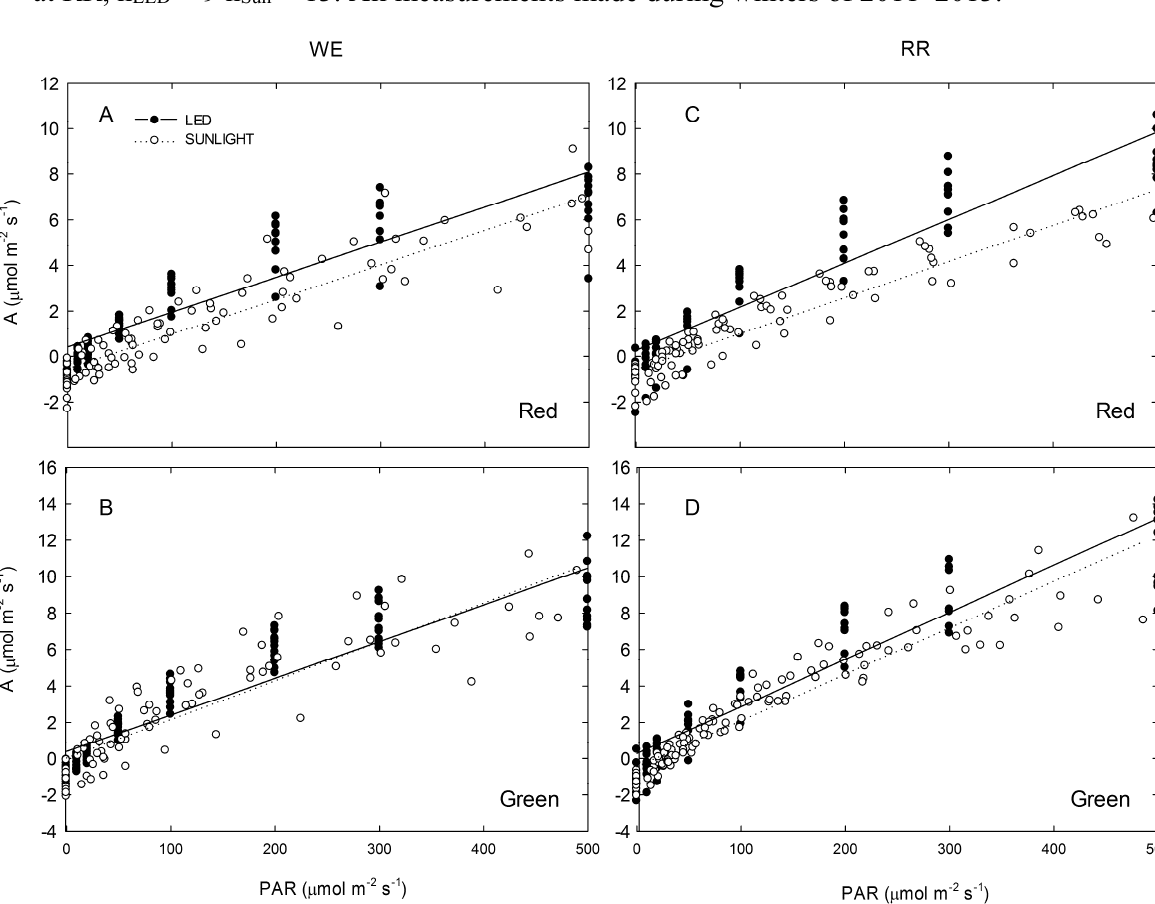
Figure 4. Linear (light-dependent) portion of light response curves measured under red/blue LED (closed symbols, solid line) versus ambient sunlight (open symbols, dashed line) at WE (left column) and RR (right column). ( A ) Red leaves at WE, n LED = 10 n Sun = 10; ( B ) Green leaves at WE, n LED = 12 n Sun = 9; ( C ) Red leaves at RR, n LED = 9 n Sun = 10; ( D ) Green leaves at RR, n LED = 9 n Sun = 13. All measurements made during winters of